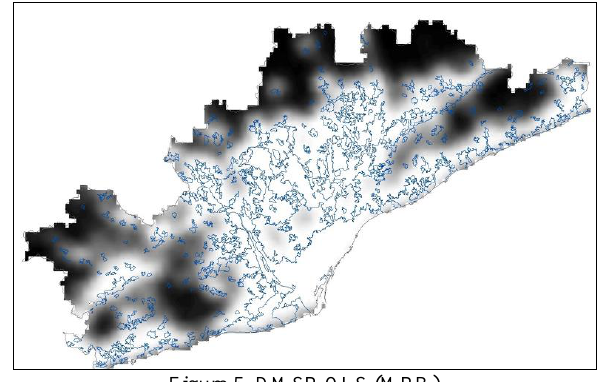
Figure 5. DMSP-OLS (MRB)